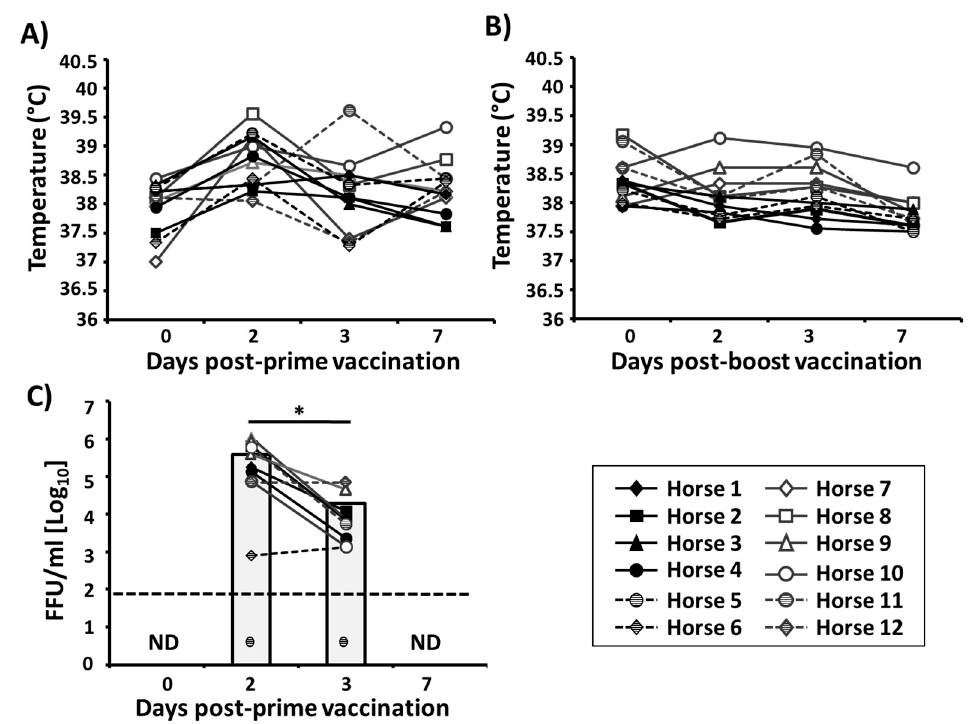
Figure 6. Attenuation of the bivalent EIV LAIV in horses: ( A , B ) Graphical representation of the rectal temperatures in vaccinated horses ( n = 12) before (day 0) and 2, 3, and 7 days after prime ( A ) and boost ( B ) vaccination with the bivalent EIV LAIV. Data represent the rectal temperature of each horse which representative symbol is indicated at the bottom-right. ( C ) Viral titers: Nasopharyngeal swabs from vaccinated horses ( n = 12) were collected on days 0, 2, 3, and 7 days after prime vaccination. Virus content was determined by immunofocus assay (FFU / mL). Individual results for each horse are represented. Bars indicate the mean of the results determined in the 12 horses. ND, not detected. Dotted black lines indicate the limit of detection (200 FFU / mL). Striped black circles below the limit of detection represent non-detected virus, horse 5. * p < 0.05 was considered statistically